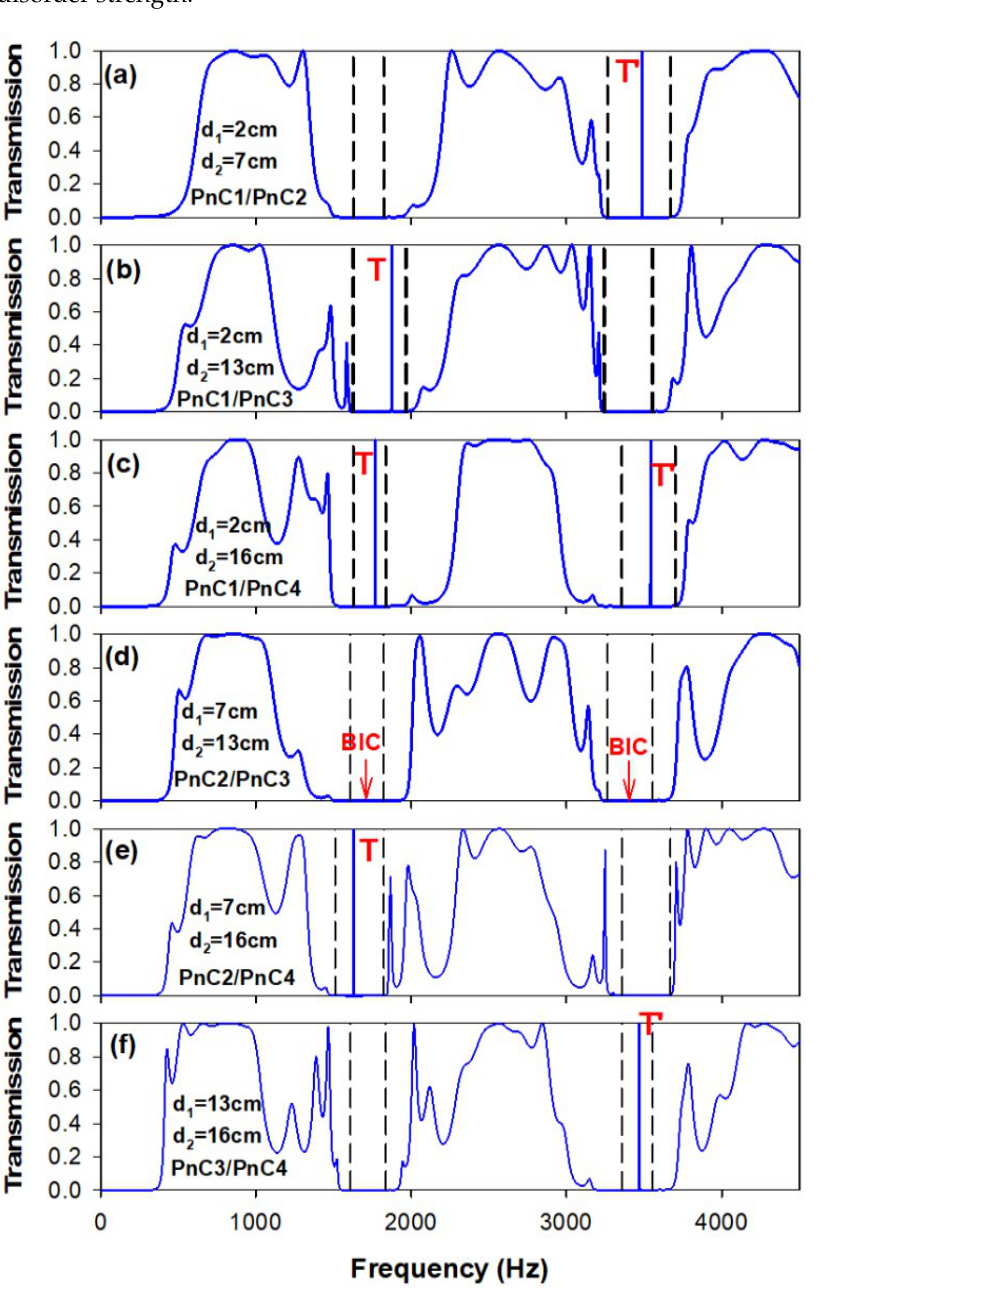
Figure 7. ( a – f ) Transmission spectra when two finite PnCs are connected together, each one made of N = 3 stubs (Figure 1c) for different combinations of PnCs pairs in Table 1, which are constructed from the four PnCs in Figure 3. The lengths of the stubs are fixed at d (cid:48) positions of the acoustic interface states in the first and second common bandgaps,